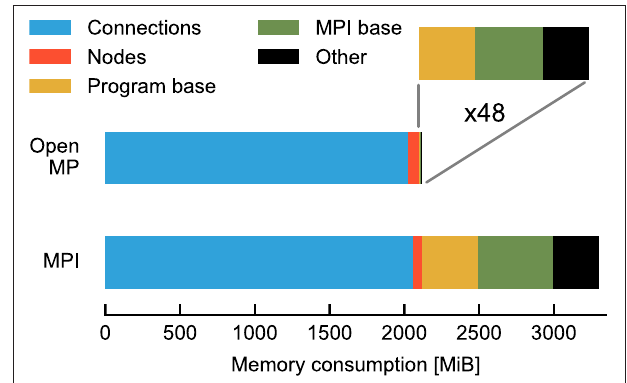
FIGURE 2 | Map of memory consumption at the end of the network construction described in Figure 1. For parallelization with OpenMP (top) 48 threads are used and, correspondingly, for MPI (bottom) 48 processes (rightmost data points in Figure 1 ). The absolute contributions to the total memory consumption are distinguished by color from left to right. In the case of OpenMP these are: synapses (blue, 2 GiB), neurons (red, 72 MiB), overhead at start of program (yellow, 6.4 MiB), initialization of MPI with MPI_Init() (green, 9.4 MiB), and other NEST data structures (black, 7.9 MiB). MPI_Init() is not required for OpenMP parallelization and shown for comparison with MPI parallelization only. The enlargement (indicated by gray lines) shows the latter three contributions (total 23.7 MiB) multiplied by 48 (1138 MiB). In the case of the MPI simulation the data are sums over all processes, the last three components occupying a total of 1184 MiB. Memory consumption is measured by the resident set size (see Section